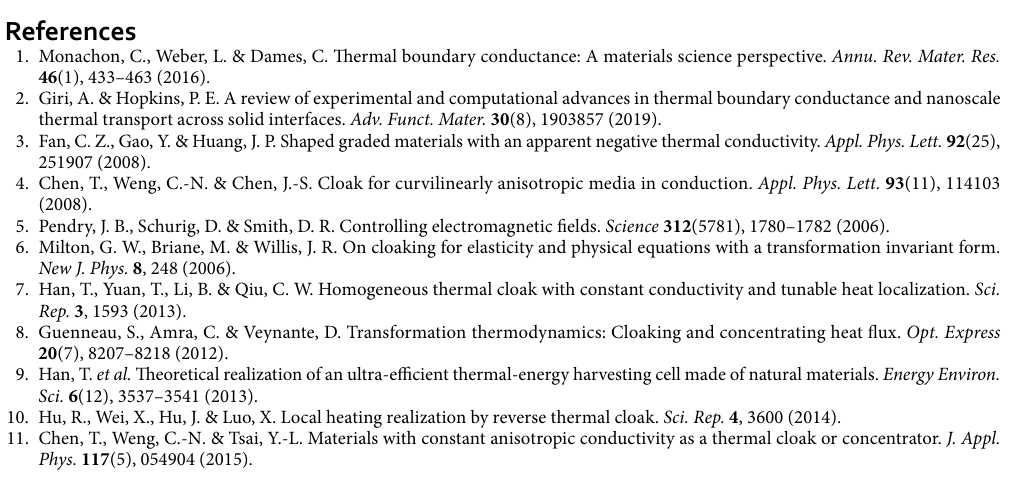
Figure 6. Homogenizations of the coated inclusion with imperfect interfaces. The first step is to consider Region I with the effect of imperfect interface at r = a . This will give a circular region with an effective isotropic ˜ k ˆ k conductivity 0 or 0 . Secondly, the composite cylinder model of an isotropic core with conductivity coated with a cylindrically orthotropic material is determined, expressed as ˜ k ˆ k homogenize a uniform conductivity CCA or CCA with an imperfect effect at r = b . This will lead to the thermal invisibility condition (3) and (5),